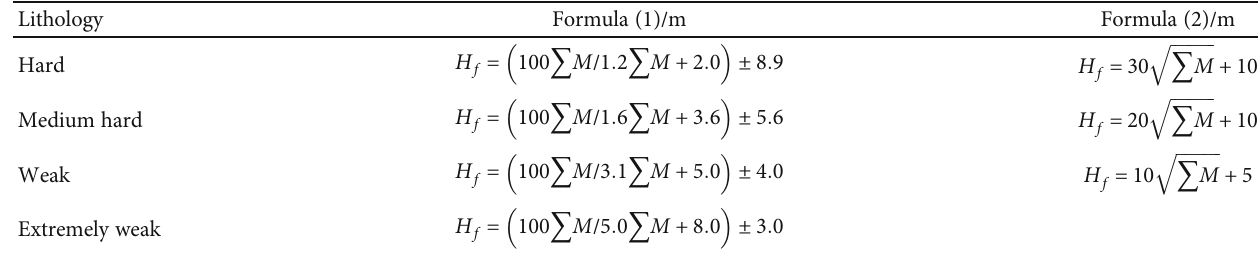
ffiffiffiffiffiffiffiffiffiffi